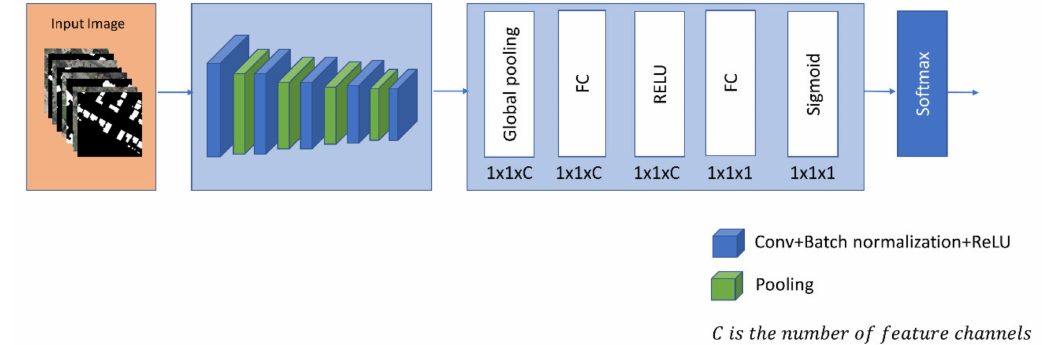
Figure 5. The structure of the attention subnetwork.